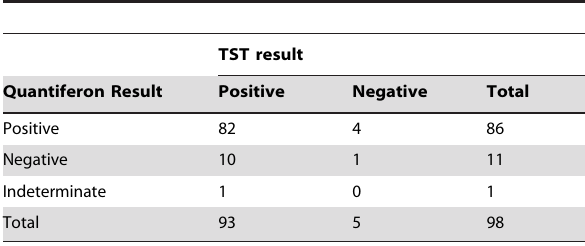
Table 2. Comparison of results for QFT-IT and TST for sputum smear positive pulmonary TB